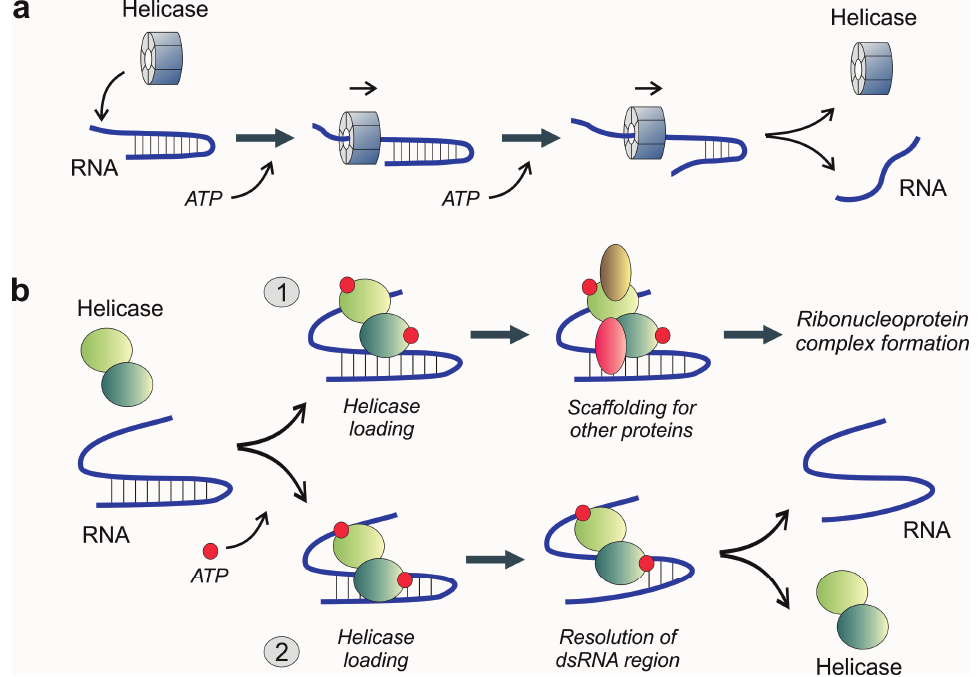
Figure 2. Schematic representation of the proposed reaction mechanisms of several groups of RNA helicases, showing the panoply of their biological activities. ( a ) Hexameric helicases belonging to SF3, SF4 and SF5 superfamilies are able to unwind and resolve RNA hybrids by coupling the ATP hydrolysis to an active mechanism that involves a displacement of the protein hexamer along the RNA strand; ( b ) Monomeric helicases are able to recognize specific RNA secondary structures; non-processive monomeric helicases will bind to dsRNA regions and use ATP to build protein-RNA complexes acting as scaffolds (1); on the other hand, processive monomeric RNA helicases (2) will resolve RNA secondary structures by a mechanism that typically involves ATP hydrolysis and a local action without displacement of the helicase along the RNA